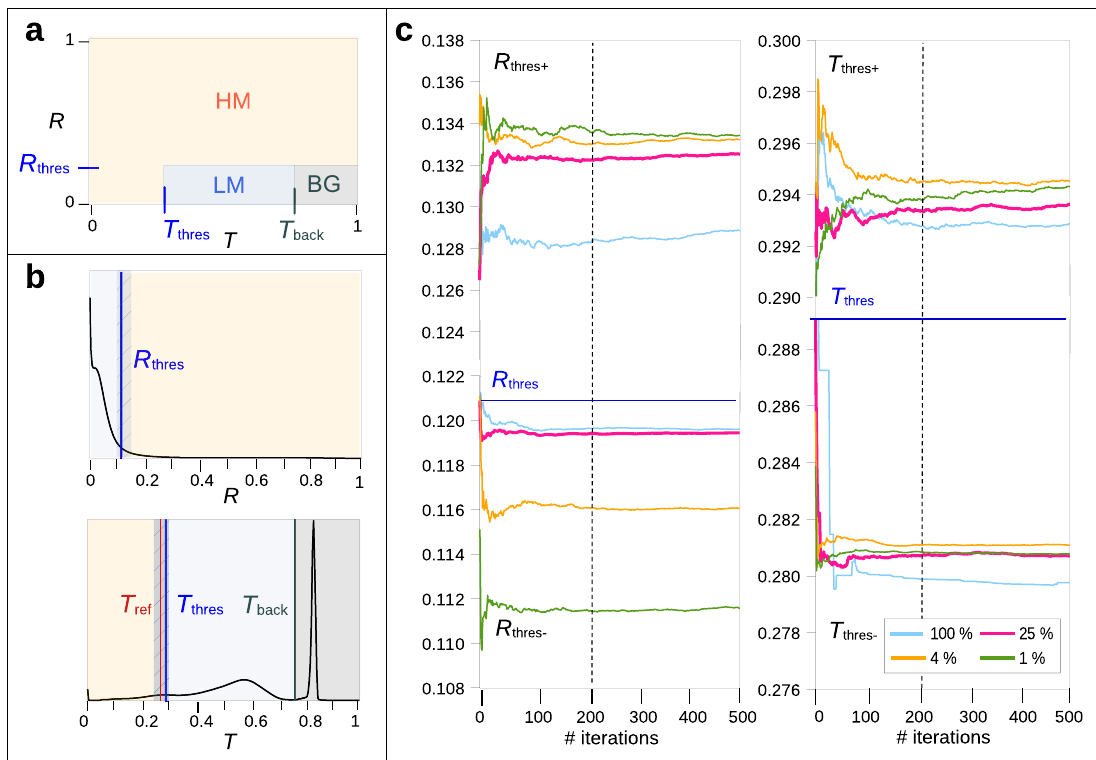
Figure 2. Optimum choice of iteration number and sample size when computing the HM-probability map, shown exemplary for a coronal rat brain section (cf. Fig. 6b). ( a ) Separation of HM-regions (orange), LM-regions (blue), and BG-regions (grey) based on the retardation R and transmittance T values of the respective image pixel. Depending on whether the values lie above or below R thres , T thres , or T back , the pixel is assigned to one or the other region. ( b ) Retardation and transmittance histograms (256 bins) of the coronal rat brain section. The parameters R thres , T ref , T thres , and T back are indicated by vertical solid lines. When computing the histograms from different sets of image pixels, the threshold parameters R thres and T thres may vary, which is indicated by striped areas (the striped areas are only shown for illustration purposes and depend on the respective set of image pixels). ( c ) Corresponding positive/negative means ( R thres + / − and T thres + / − ), computed for up to 500 iterations and different sample sizes (100%, 25%, 4%, 1% of all image